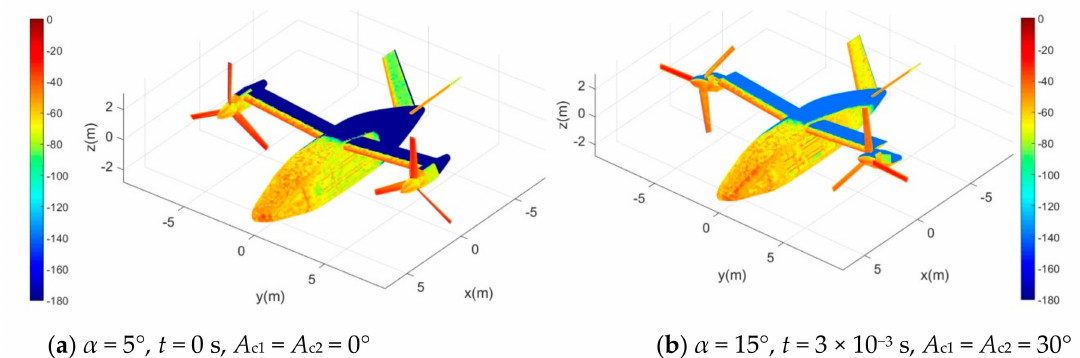
Figure 9. Surface scattering characteristics of aircraft, β = 0 ◦ , f rh = 10 GHz, n r1 = n r2 = 1500 r/min, RCS unit: dBm 2 . ( a ) SurFigure 5. t = 0 s, A c1 = A c2 = 0 ◦ . ( b ) Surface scattering characteristics at α = 15 ◦ , t = 3 × 10 − 3 s, A c1 = A c2 = 30 ◦ .